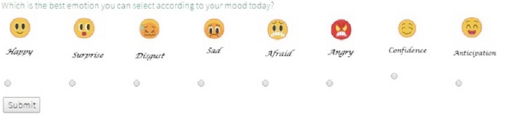
Figure 4: Emotion gathering.